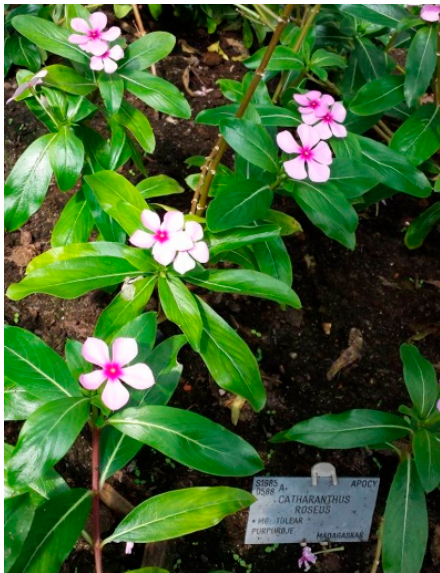
Figure 18. Catharanthus roseus (The Museum of Natural Medicine & The Pharmacognostic Collection, University of Copenhagen).